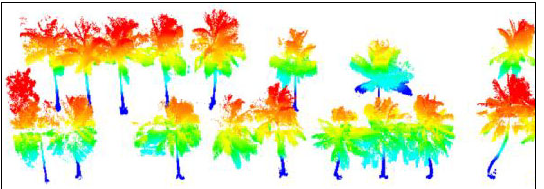
Figure 3. Point cloud view of extracted street trees.